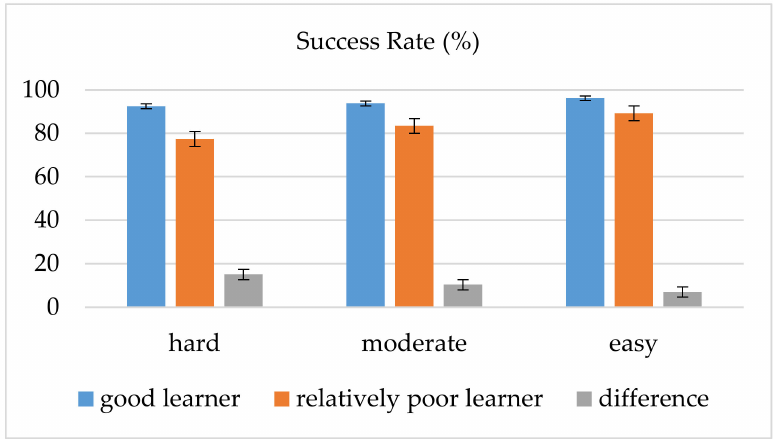
Figure 4. Success rates of good and relatively poor